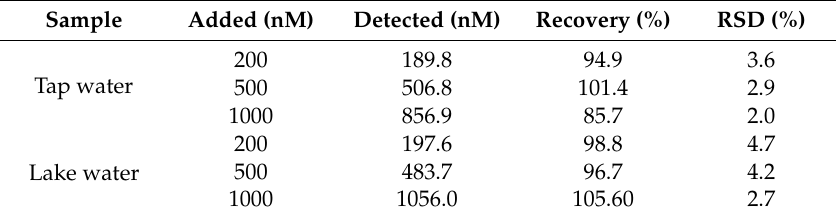
Table 1. Determination of Hg 2 + in tap water and lake water samples. (n = 3).